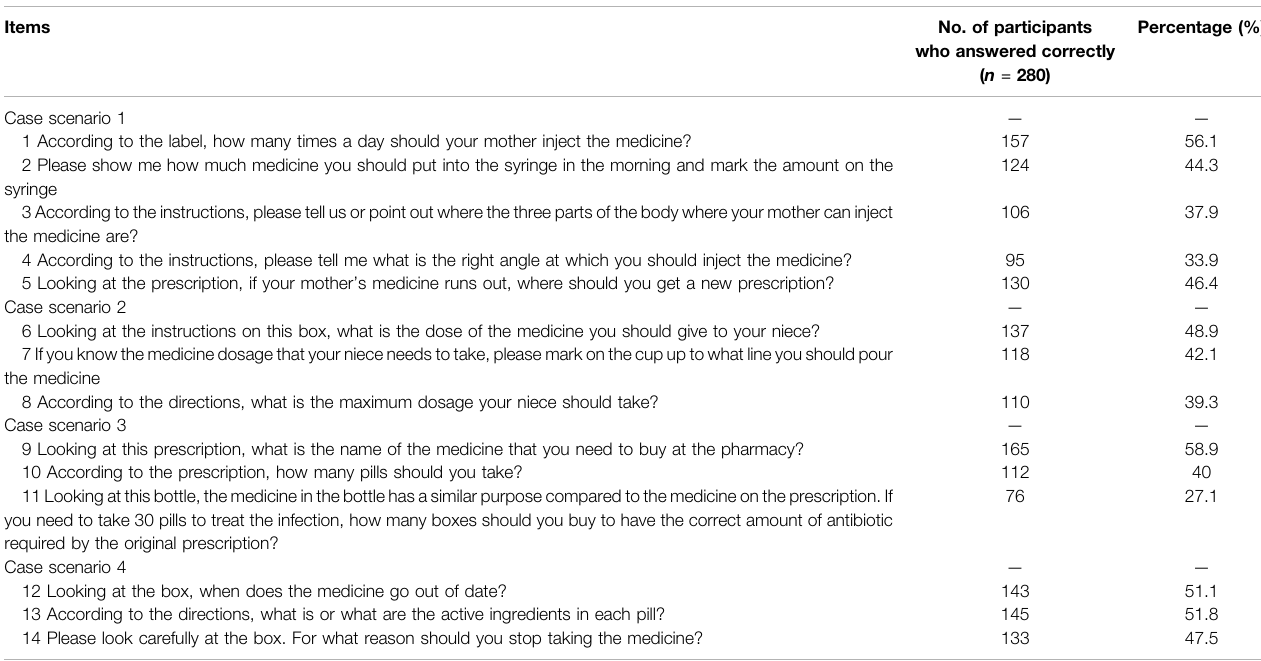
TABLE 2 | | Medication literacy for inpatients with CHD ( N (cid:1)